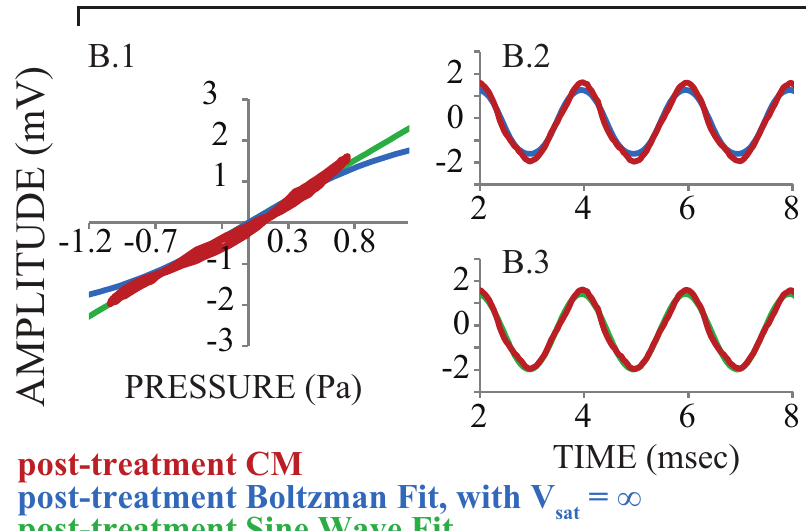
Fig 10. An analysis of cochlear microphonic (CM, red) measuredfrom inside the endolymphatic space of the third cochlear turn in an exemplar ear before and after 13 mM HP β CDtreatment. Pre- treatment (top panels):the best fit to the empiricalCM was achievedwith a typical Boltzmannanalysis(Panel A, blue). Post-treatment (bottom panels):the best fit to empiricalCM data was to a simple sine wave (Panel B, light green). These analysessuggest that mechanoelectric transduction was effectively linearizedfor the relatively high 90 dB SPLs used to evoke the CM. It is likely that saturation, or nonlinearity, of mechanoelectric transduction after 13 mM HP β CDtreatment occurs at highersoundpressure levels that what we used here. and transient enhancement of EP measurements (Fig 3) made during 13 mM HP β CD treatment could be explained if decreased current flow through OHCs increases the overall resistance between endolymph and perilymph. That is to say, decreased current flow would reduce the